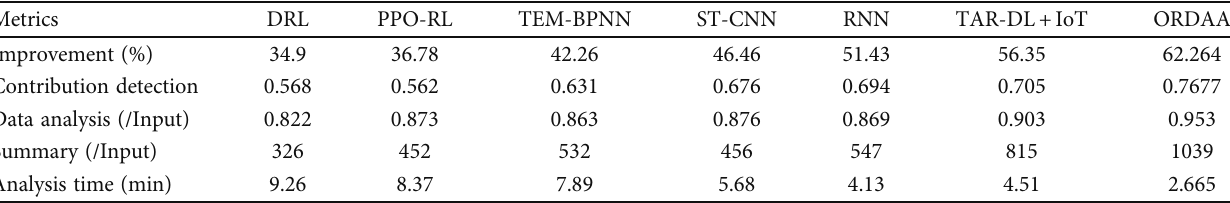
Table 3: Comparative analysis results for years.